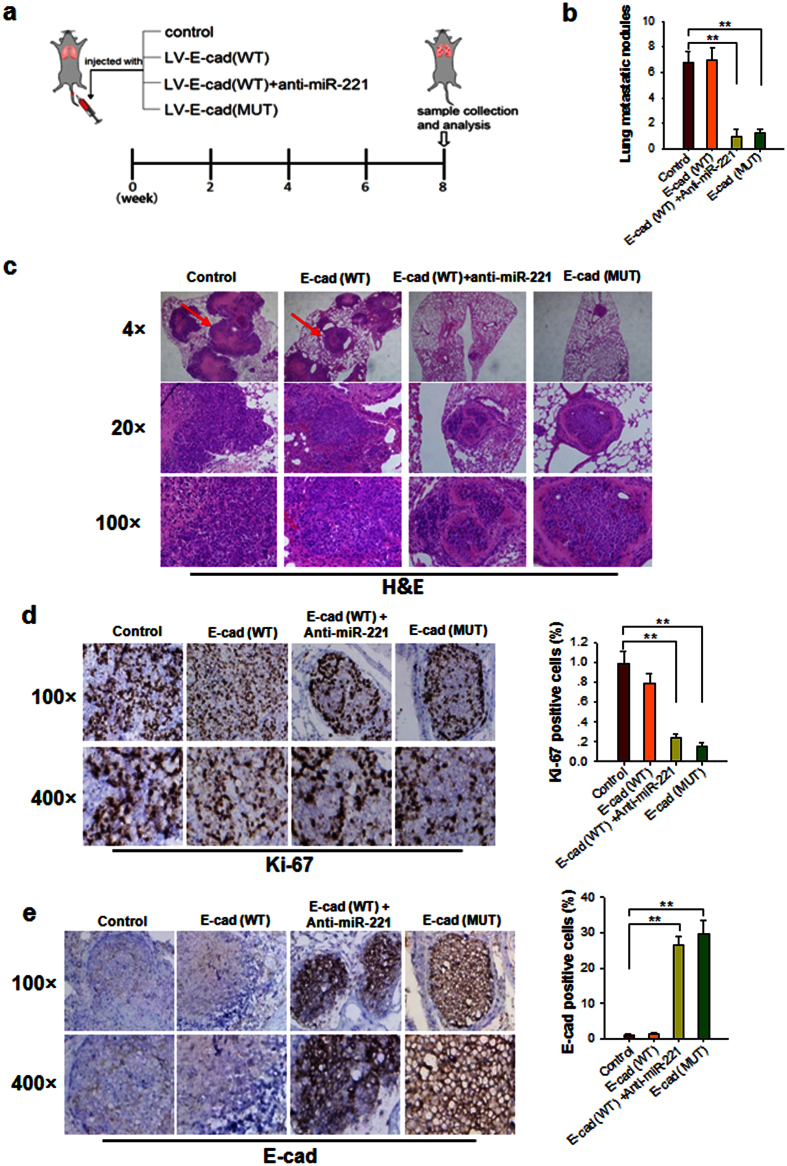
E-cadherin inhibits the lung colonization of MDA-MB-231 cells.(a) Experimental design. Immunocompromised mice were injected through tail vein with control MDA-MB-231 cells or MDA-MB-231 cells that were stably transfected with E-cad (WT), E-cad (WT) plus anti-miR-221 or E-cad (Mut). After 8 weeks, mice were sacrificed and lungs were extracted. (b) the numbers of tumor nodules in the lungs. Results were derived from five mice in each group. (c–e) Mouse lungs were subjected to H&E staining (c) and immunohistochemical staining for Ki-67 (d) and E-cadherin (e), respectively. Left panel: representative image; right panel: quantitative analysis of images. Results are presented as the mean ± SEM (n > 3). **P < 0.01.